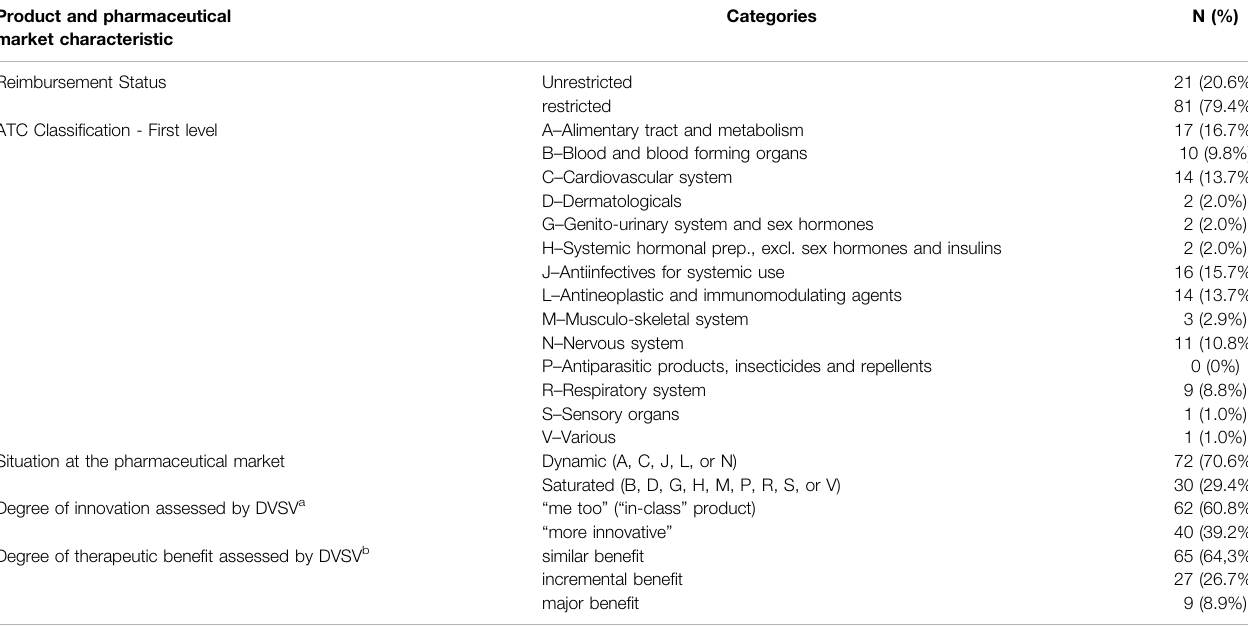
TABLE 1 | Descriptive characteristics of pharmaceutical products included in the study.